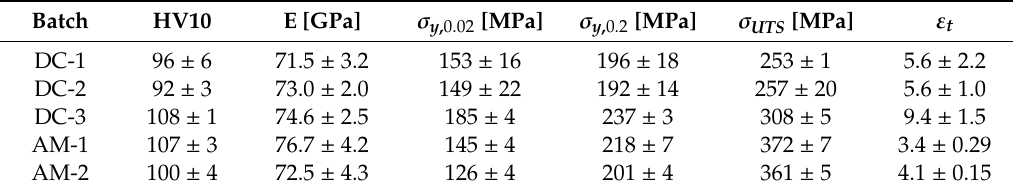
Table 3. Hardness and quasi-static properties of die-cast (DC) and additively manufactured (AM) alloy AlSi7Mg0.3 and AlSi12.